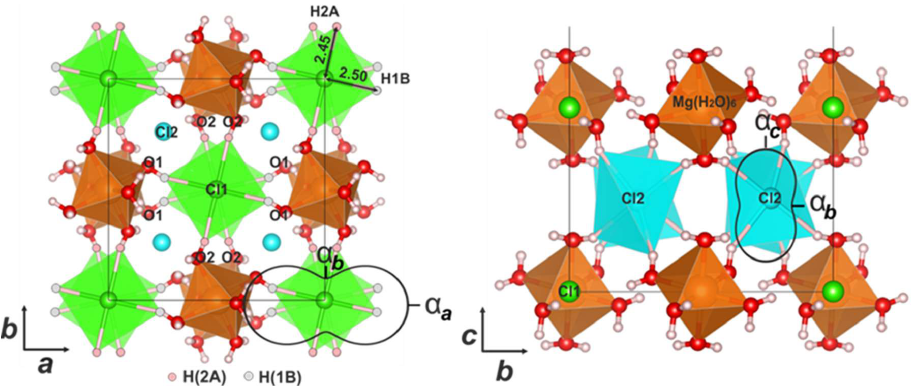
Figure 6. The crystal structure of NH 4 MgCl 3 ·6H 2 O and a section of the figure of thermal expansion coefficients oriented relative to the crystallographic axes (ammonium is excluded for